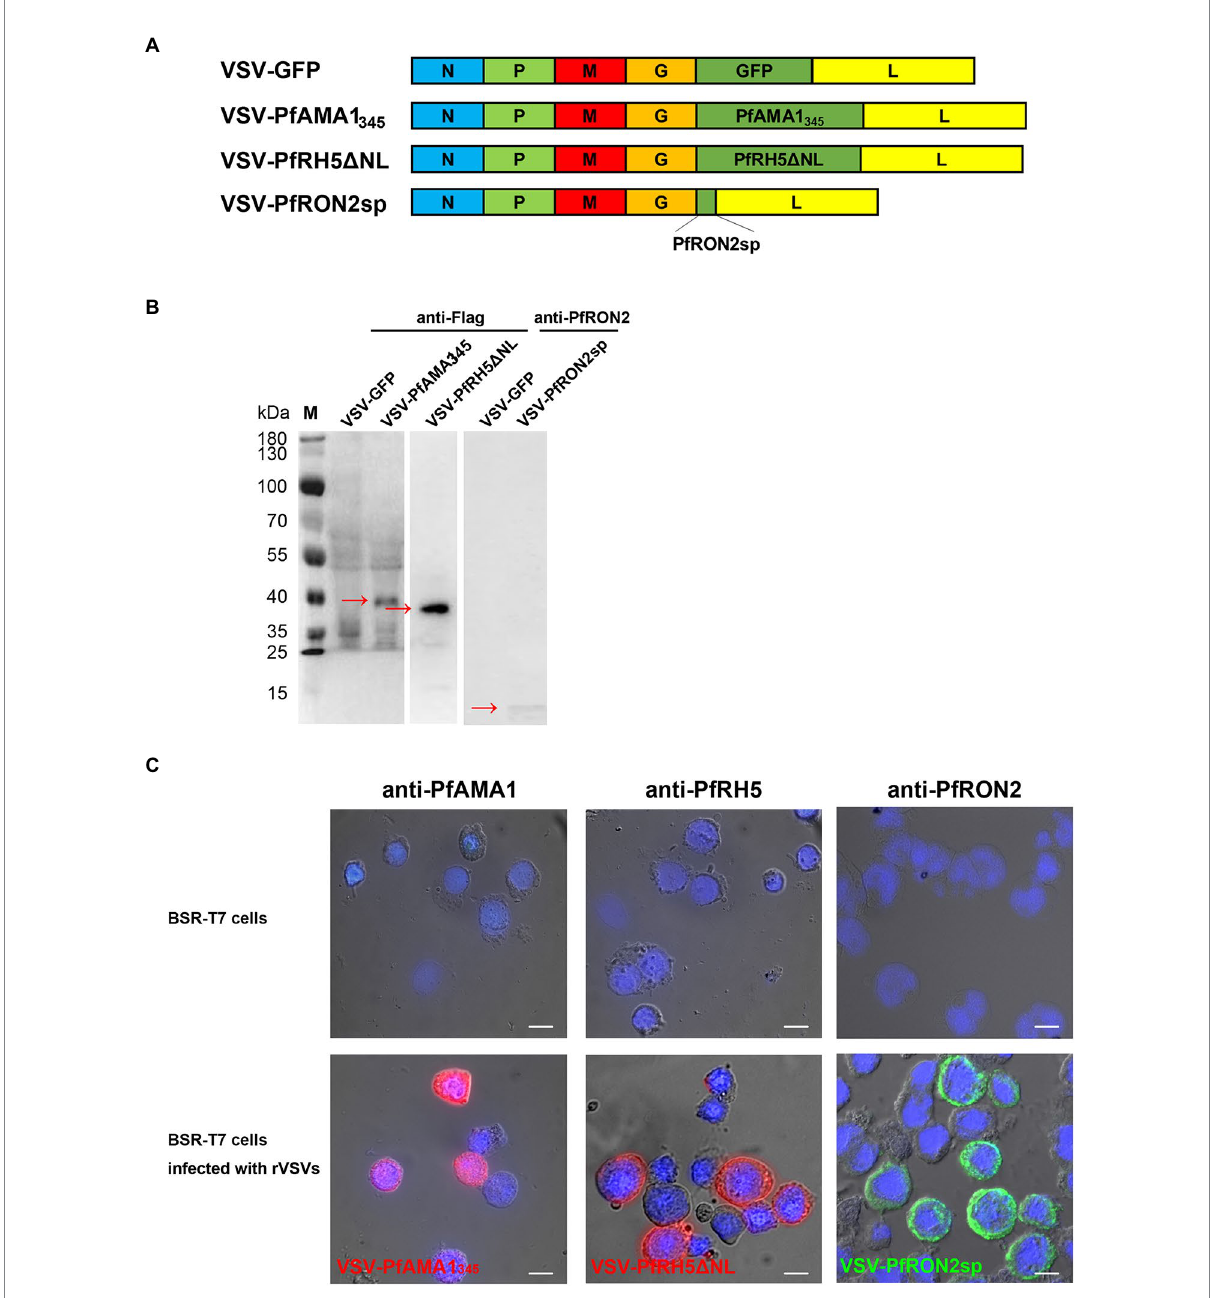
FIGURE 2 Construction and characterization of recombinant VSV-PfAMA1 345 , VSV-PfRH5 Δ NL, and VSV-PfRON2sp. (A) Construction of VSV-PfAMA1 345 , VSV- PfRH5 Δ NL, VSV-PfRON2sp, and VSV-GFP. Gene encoding Plasmodium falciparum antigen PfAMA1 345 , PfRH5 Δ NL, and PfRON2sp were cloned into VSV vector pXN2 between the G and L genes. The recombinant VSV pseudotype was cloned into pXN2-GFP, recombinant pXN2, and other plasmids encoding VSV nucleocapsid (N), phosphoprotein (P), and large polymerase subunit (L) to reconstruct the VSV genome. (B) BSR-T7 cells infected with rVSVs were harvested and analyzed 12 h post-infection by western blotting using anti-Flag antibody for VSV-PfAMA1 345 and VSV- PfRH5 Δ NL and anti-PfRON2 antisera for VSV-PfRON2sp. BSR-T7 cells infected with VSV-GFP were used as the control. (C) Indirect immunofluorescence was performed to study PfAMA1 345 , PfRON2sp, and PfRH5 Δ NL expression in BSR-T7 cells infected with recombinant VSVs 12 h post-infection using anti-PfAMA1, PfRH5, or PfRON2sp antisera obtained from antigen-immunized mice. Non-transfected BSR-T7 cells were used as the control. The bar represents 10